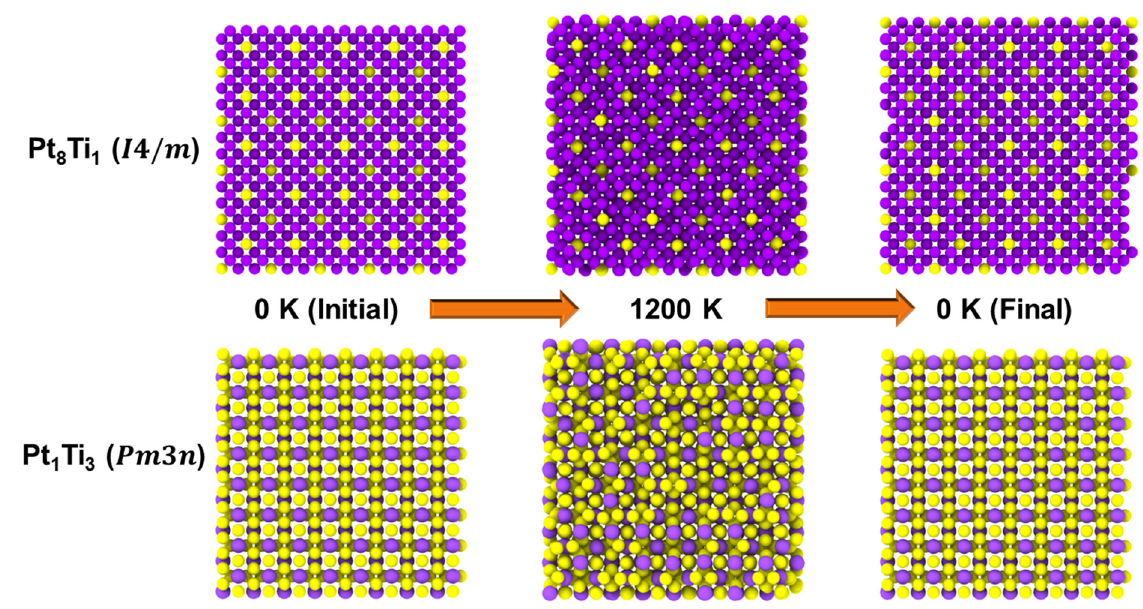
Figure 5. Atomic configurations of D 1 a -Pt 8 Ti and A 15-PtTi 3 intermetallic compounds at 0 K (before heating), 1200 K (after heating), and 0 K (after cooling). The purple and yellow atoms represent Pt and Ti, respectively.